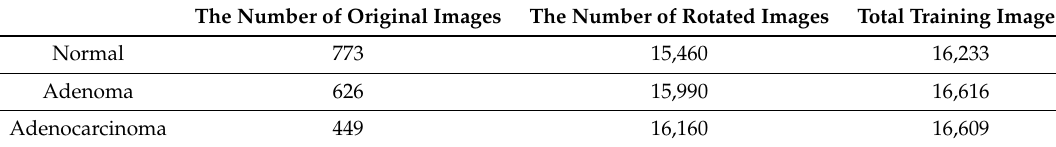
Table 1. Configuration of our training dataset.